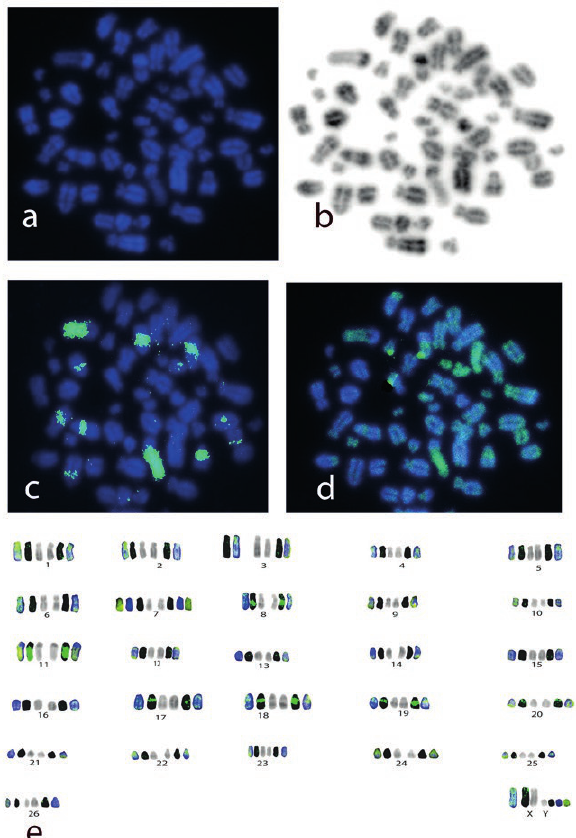
Figure 1. Metaphases of S. cay paraguay in DAPI (a), in DAPI inverted (b), Cap-A probe mapping (c), CMA3/DAPI stains (d), the reconstructed karyotype of S. cay paraguay from the metaphase in a) after sequential CMA3/ DAPI, DAPI inverted, FISH with Cap-A probes